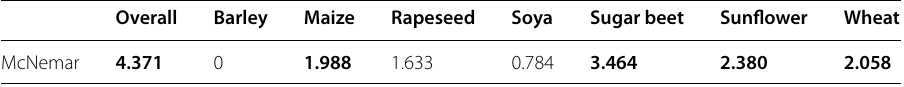
Table 6 McNemar test statistic comparing PFT and BMP on Vojvodina dataset, overall and for specific